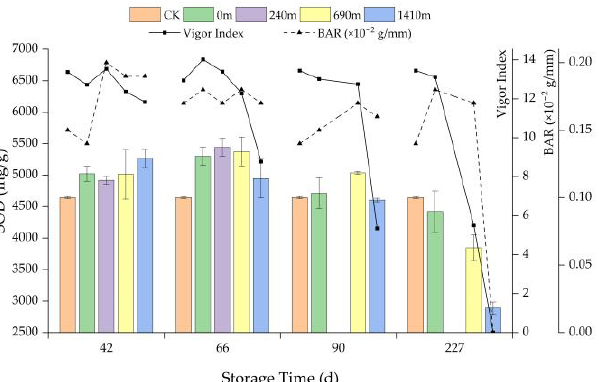
Figure 5. Variation of SOD activity of canola seeds in deep underground storage with storage duration and depth. The bar graph showed the variation of SOD activity, the solid line in the line graph showed the variation of vigor index, and the dashed line showed the variation of biomass accumulation rate (BAR).